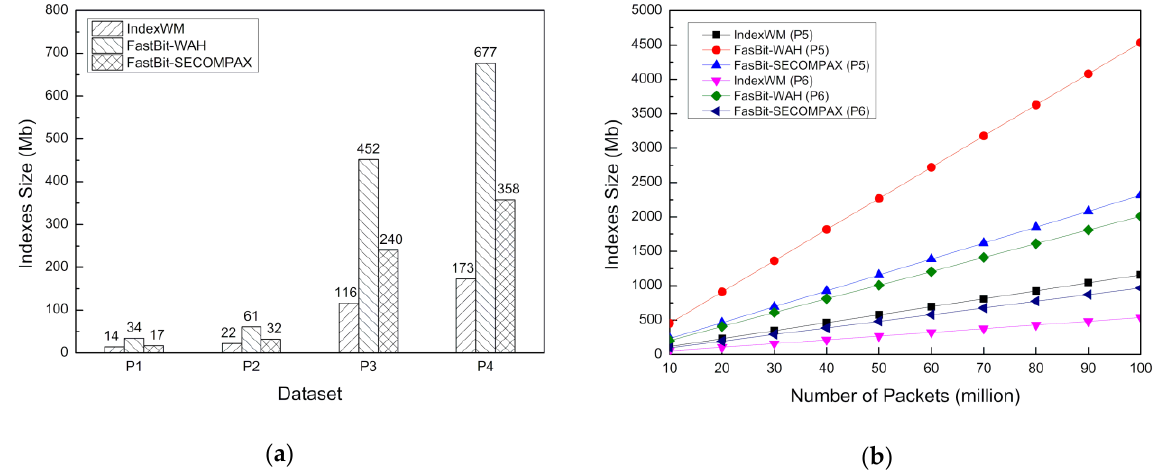
Figure 10. A comparison of storage consumption for indexing. ( a ) Storage consumption on datasets P1, P2, P3 and P4; ( b ) storage consumption on datasets P5 and P6 as a function of the number of packets.